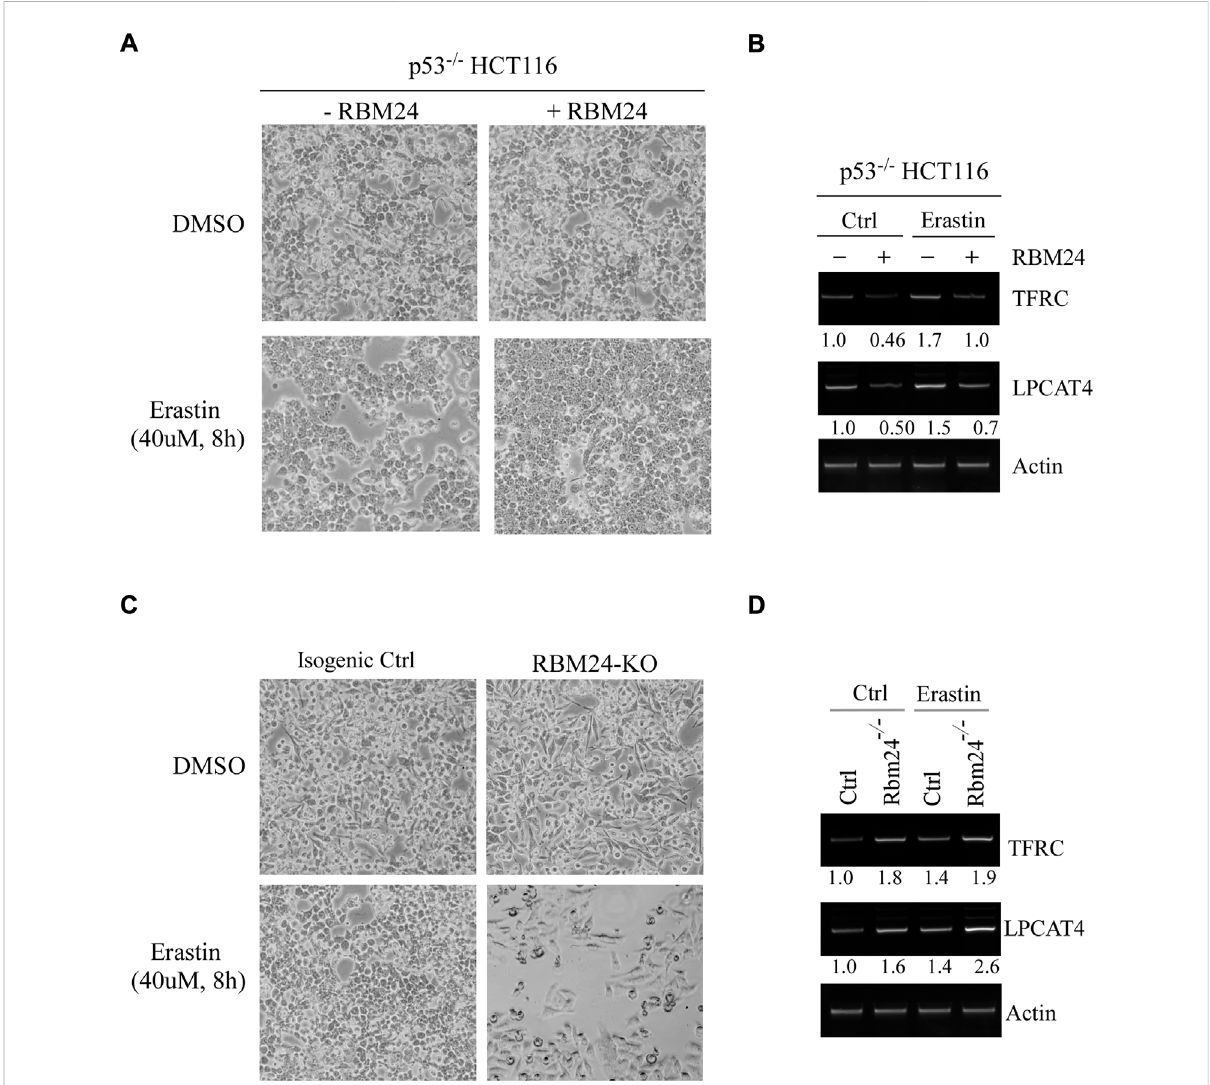
RBM24 protects p53 − / − HCT116 cells from ferroptosis. (A) p53 − / − HCT116 cells were uninduced or induced to express RBM24 for 24 h, followed bymocktreatmentortreatmentwithErastin(40 uM)for8 h.Representativemicroscopicpicturesweretakenattheendpoint. (B) ThelevelsofTFRC, LPCAT4, and actin mRNAs were measured in p53 − / − HCT116 cells treated as in (A) . The relative mRNA abundance was shown below each lane. (C) IsogeniccontrolandRBM24-KOHCT116cellsweremock-treatedortreatedwithErastin(40 μ M)for8 h,followedbymicroscopicimaging. (D) The levels of TFRC, LPCAT4, and actin mRNAs were measured in cells treated as in (C) . The relative mRNA abundance was shown below each